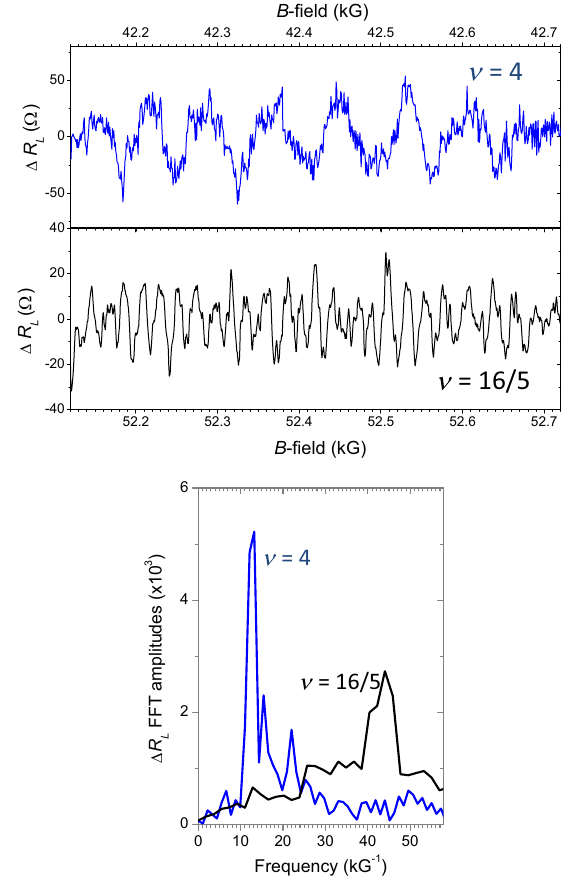
FIG. 4. A comparison of magnetic field sweeps and their Fourier transforms at ν ¼ 4 and ν ¼ 16 = 5 in the same sample (sample 6, preparation 25, device type b, T ∼ 20 mK). A dominant spectral feature observed at ν ¼ 16 = 5 is located at approximately 3 times the frequency of the integer peak, as expected from Eq. (2).